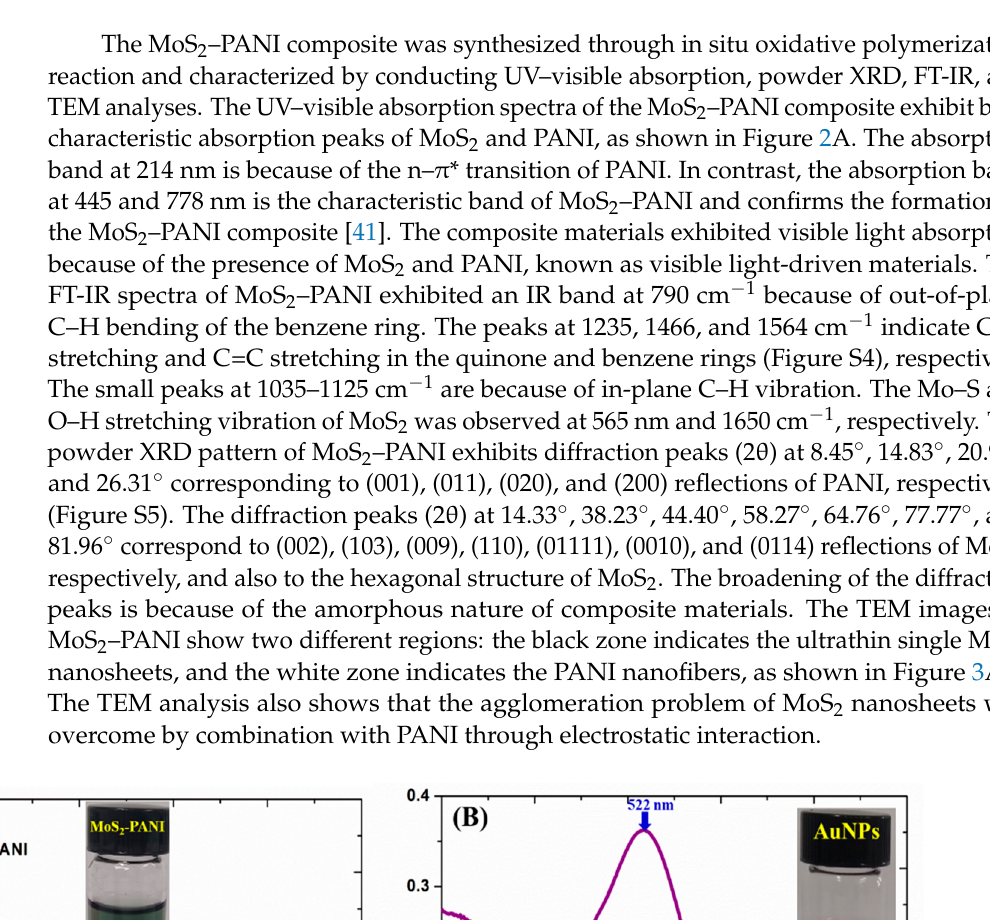
Figure 1. TEM images of MoS 2 : ( A ) low-magnification image; ( B , C ) high-resolution TEM image of layered MoS 2 .